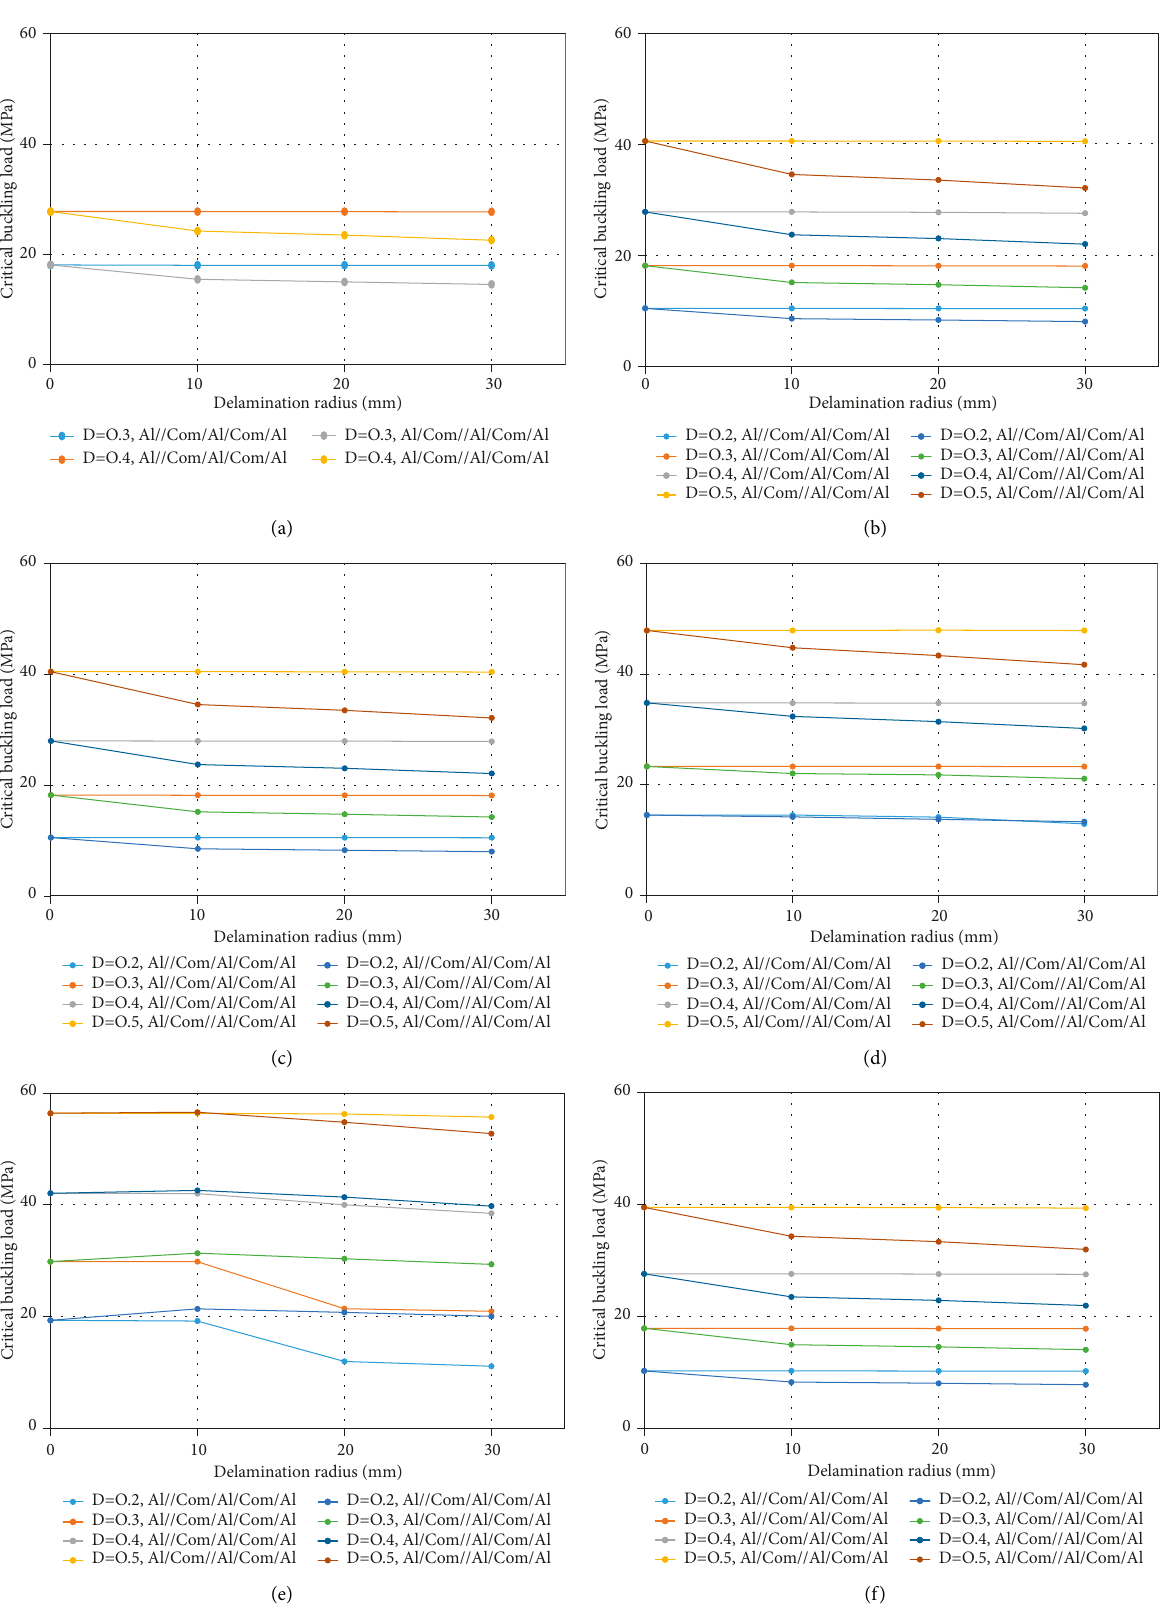
Figure 6: Critical shear buckling load of. (a) GLARE 1-3/2-D, (b) GLARE 2-3/2-D, (c) GLARE 3-3/2-D, (d) GLARE 4-3/2-D, (e) GLARE 5- 3/2-D, and (f) GLARE